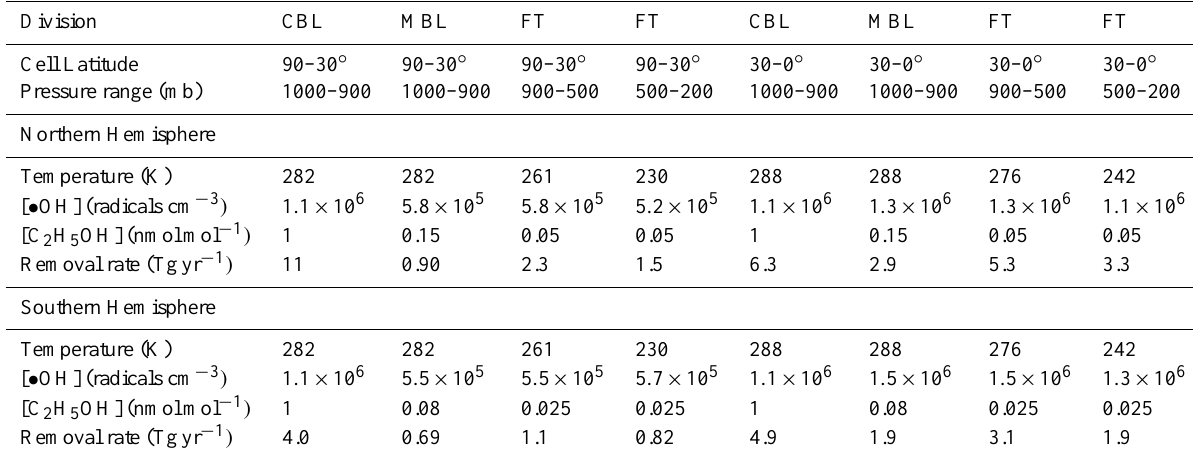
Table 4. Ethanol removal rates from the various regions of the atmosphere by reaction with hydroxyl radicals, and the information used for the